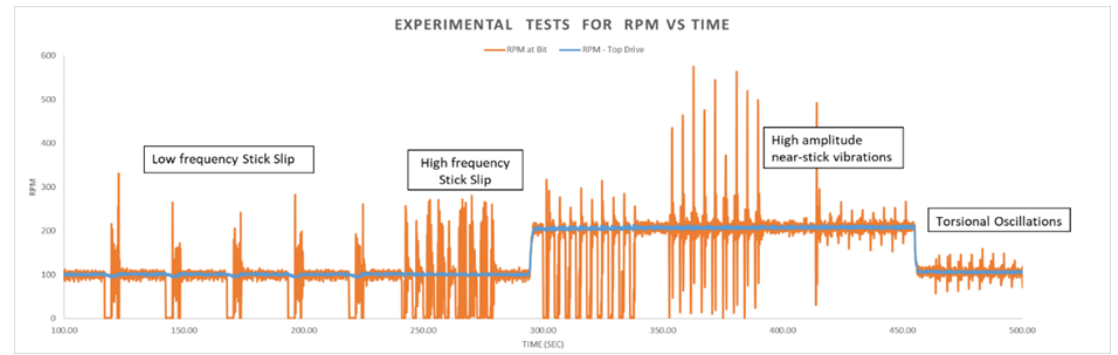
Figure 21. Range of experimental results for examining torsional vibration in the setup.